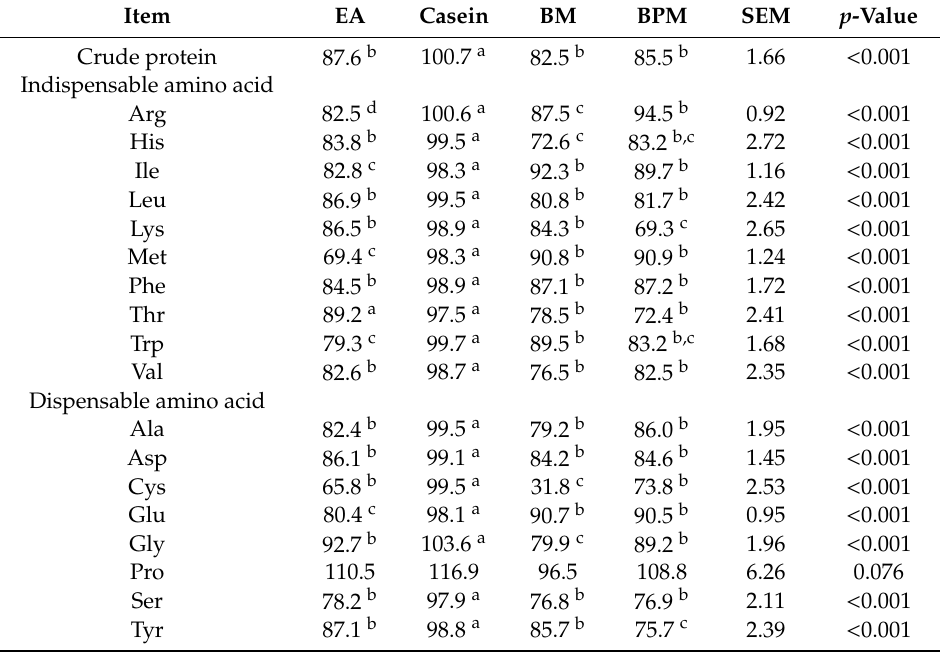
Table 6. Standardized ileal digestibility (%) of crude protein and amino acids for experiment 1 1,2 .